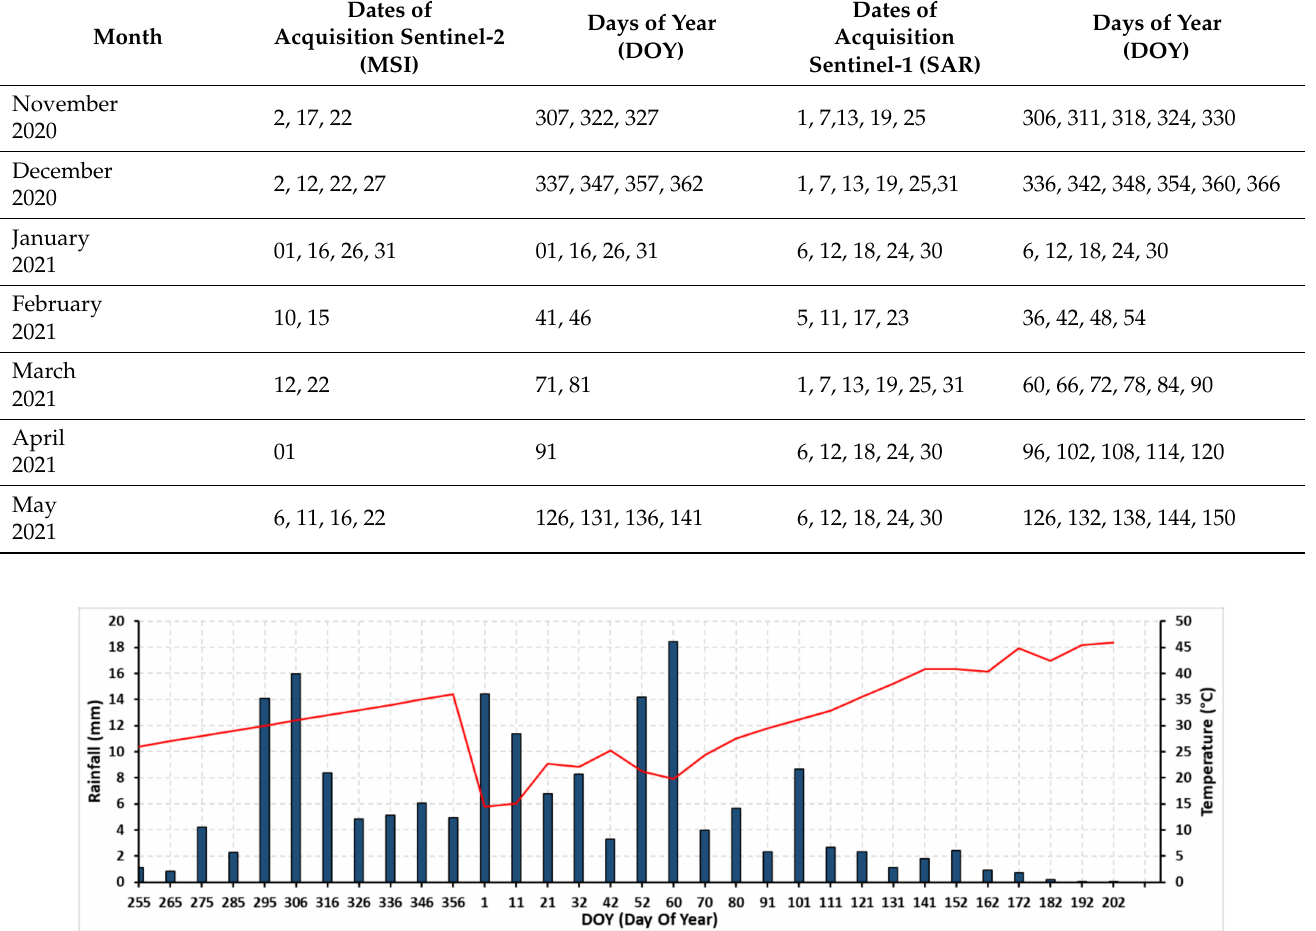
Figure 3. An ombrothermal diagram of climatic conditions in the TIP from September 2020 to July 2021 (precipitation is represented by the blue bars and temperature by the red